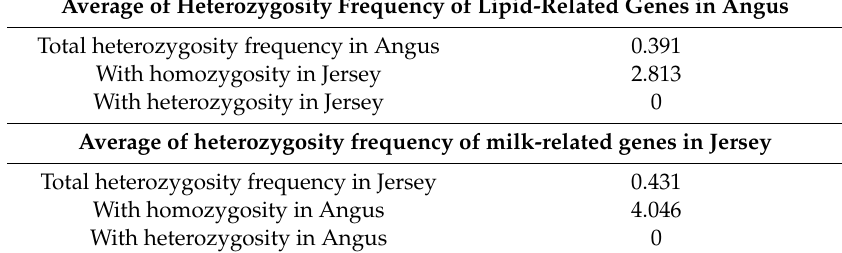
Table 1. The average of the heterozygosity frequency for the lipid-intramuscular fat-related genes in Angus and milk-related genes in